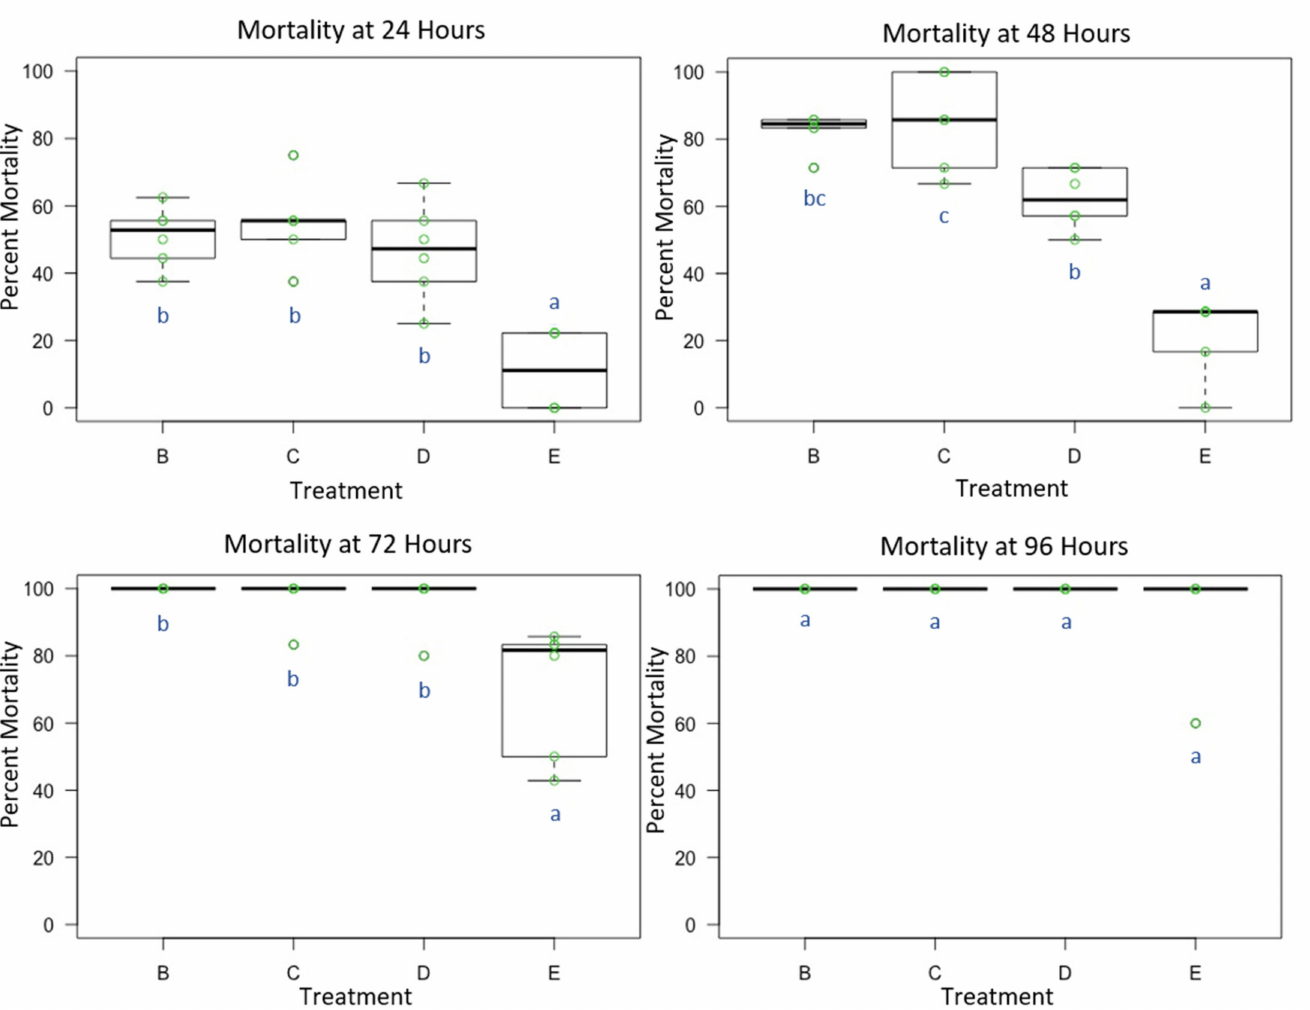
Figure 2. Female Osmia lignaria Acute Contact Toxicity Following Whole-Body Contact Exposure to Premix Insecticides: Female Osmia lignaria mean, 1st and 3rd quartile percent mortality following whole-body contact exposure to each insecticide mixture (Experiment 2) at 24, 48, 72 and 96 h. Data on the x-axis indicate each insecticide treatment, and data on the y-axis indicate percent mortality. Insecticide treatments: B = TLC, C = IBC, D = CLC, E = MS. All jars in a treatment containing the respective percent mortality are represented by a single green point. Letters (a, b, c) indicate significant difference at p < 0.05 (pairwise comparison). Information related to control mortality is given in the result